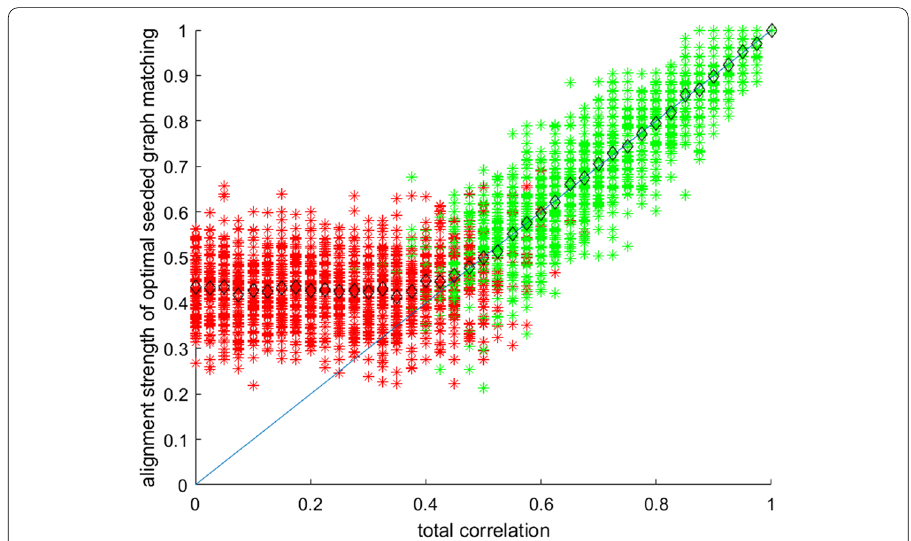
Fig. 1 For each ̺ e from 0 to 1 in increments of .025, alignment strength of ˆ ϕ for 100 independent realizations when all Bernoulli probabilities were 0.5 (in particular, ̺ T = ̺ e ), with